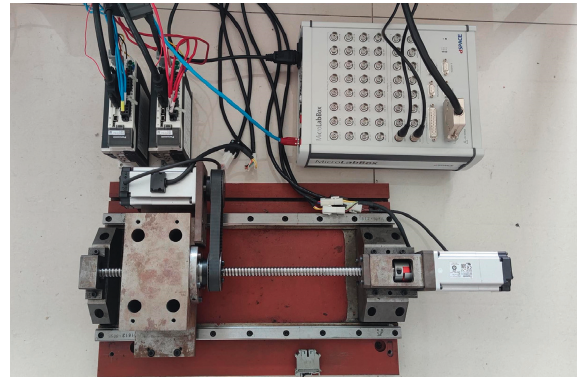
Figure 5: Test bench of two-axis differential microfeed system. Figure 6: Color laser coaxial displacement measuring